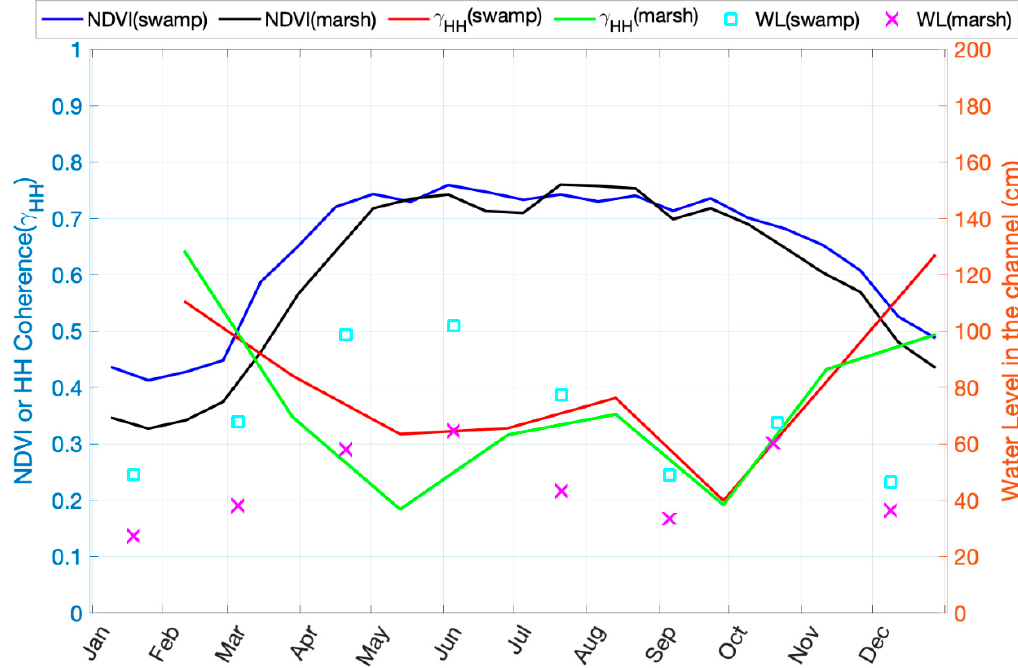
Figure 6. Seasonal trends of HH-coherence, NDVI, and water level in the channel for both swamps and marshes extracted at CRMS station locations. The curves come from the average of available data during 2007 and 2010.